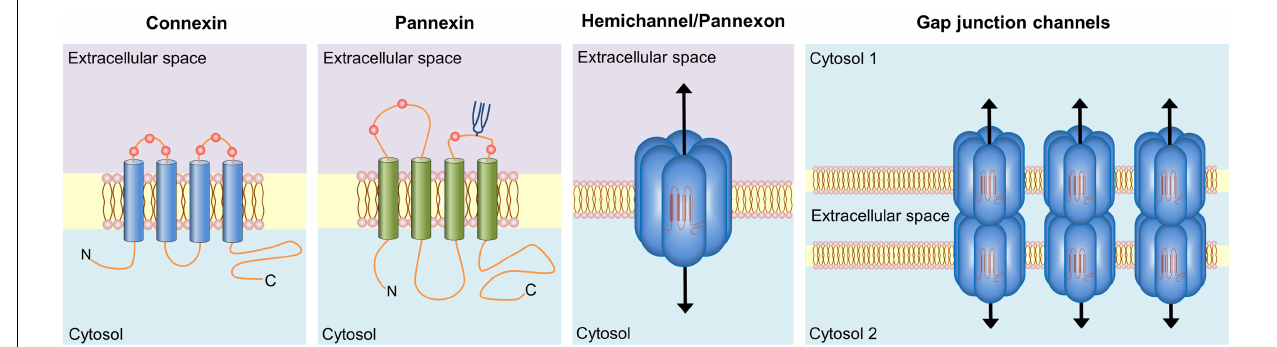
FIGURE 2 | Basic structure of connexin and pannexin-based channels. Connexins and pannexins share a similar membrane topology with four α -helical transmembrane domains connected by two extracellular loops and one cytoplasmic loop; both the amino- and carboxy-termini are intracellular. The relative positions of the extracellular loop cysteines (red balls) and glycosylated asparagines (blue branches) are also shown. Hemichannels (also known as connexons) are formed by the oligomerization of six subunit connexins around a central pore. Pannexons are single membrane channels that are composed of six pannexin subunits. Recently, a band pattern more consistent with an octamer than a hexamer was observed in Panx2 by cross-linking studies and native gels of purified homomeric full-length and C-terminal truncation mutants (Ambrosi et al., 2010). Under resting conditions, hemichannels and pannexons remain preferentially closed, but they may be activated by diverse physiological and pathological conditions and offer a diffuse transmembrane route between the intra- and extracellular milieu. Hemichannels dock each other to form functional cell-to-cell channels termed gap junction channels (right panel). Gap junction channels aggregate in well-known anatomical structures called gap junctions to facilitate the intercellular cytoplasmic exchange of metabolites, second messengers and